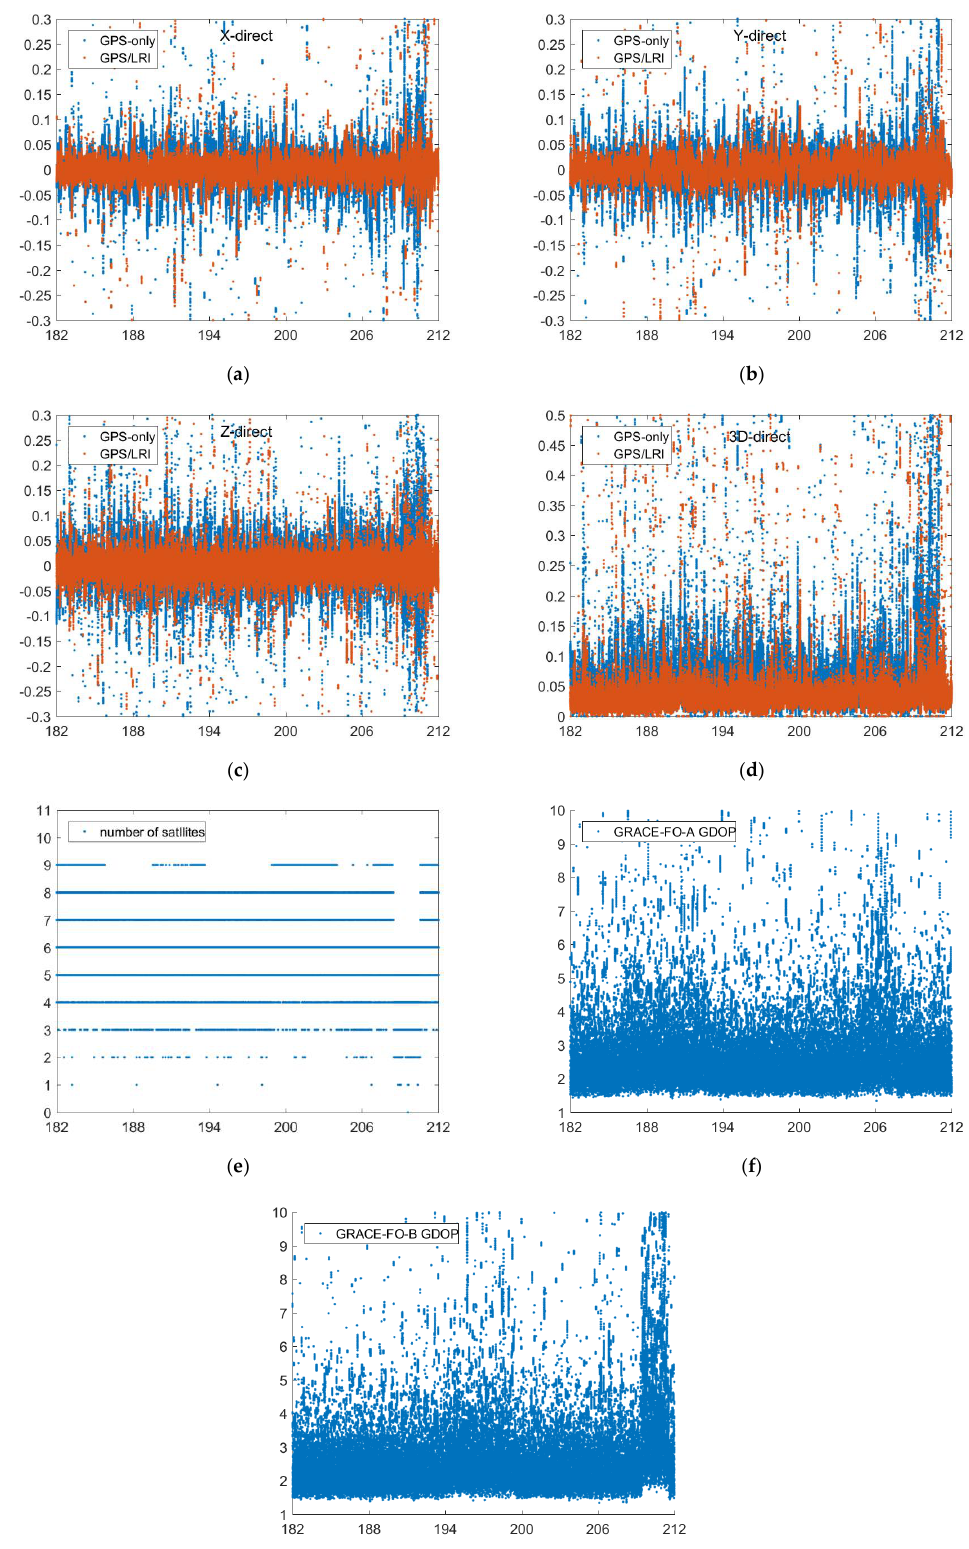
Figure 4. Reference orbit check for GRACE-FO in the X, Y, Z, 3D (X, Y, Z are components of the baseline vector, unit: m,( a – d )) directions (days 182–212), number of satellites for each epoch ( e ) and GDOP ( f , g ).